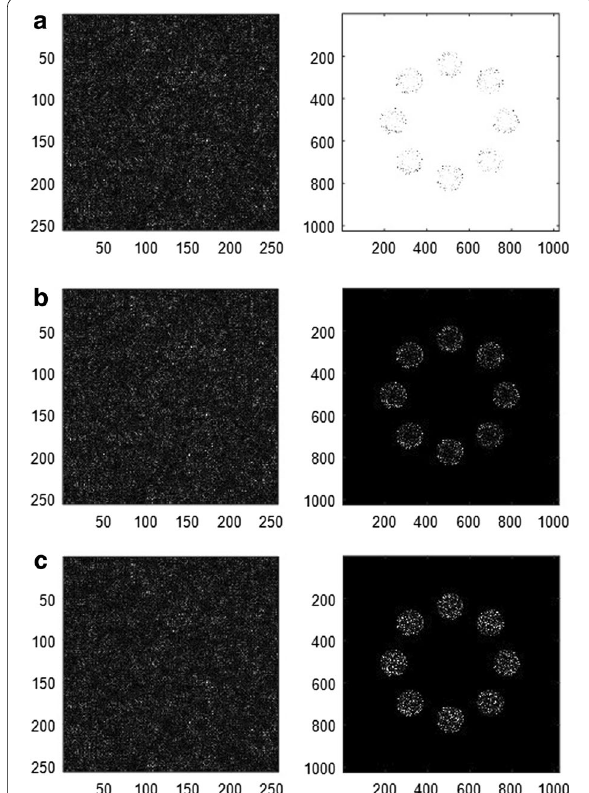
Fig. 8 a Speckle formed using diffuser and the eight-conic aperture shown in Fig. 1c and its reconstruction. b Speckle formed using diffuser and the eight-linear aperture shown in Fig. 2a and its reconstruction. c Speckle formed using diffuser and the eight-uniform circular aperture shown in Fig. 4a and its